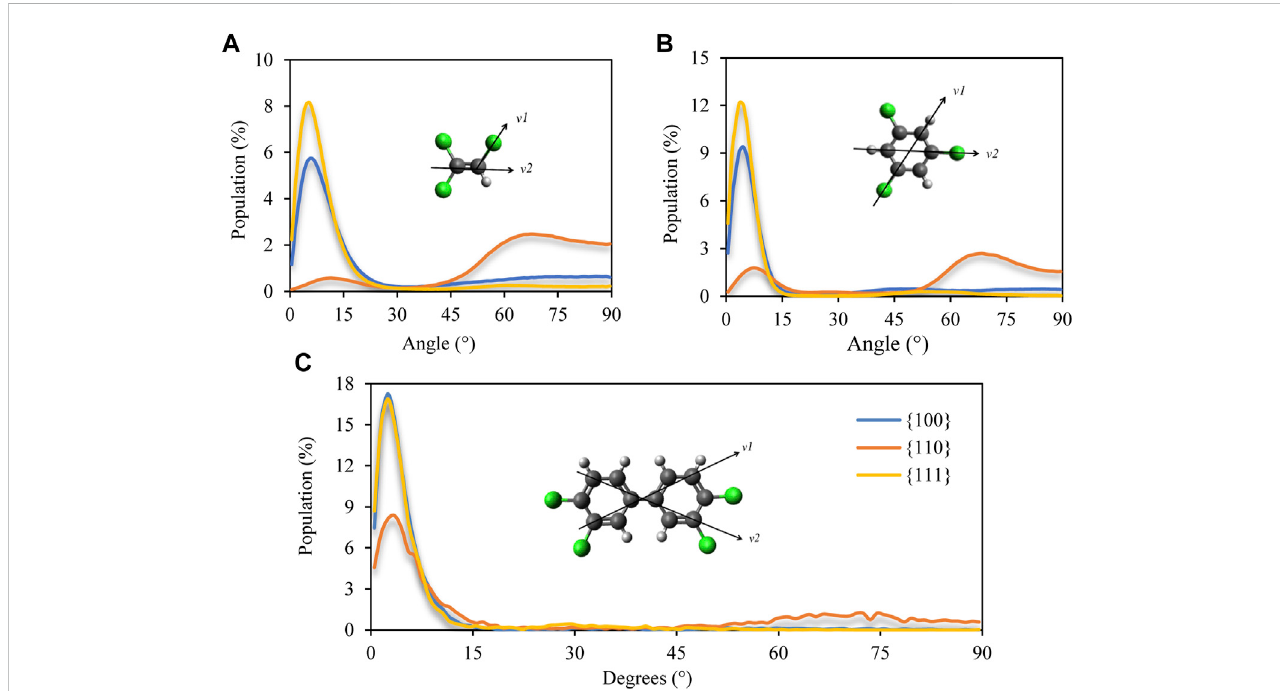
FIGURE 3 Distributionofanglesbetweenthemolecularface-normalvector(de fi nedbythecrossproductofvectorsv1andv2)andsubstratenormaldirection.Data for (A) TCE at 230 K, (B) for TCB at 360 K and (C) for PCB77 at 500 K. Zero degree implies average parallel orientation with respect to Pd surface (face- fl at) while 90 degrees implies perpendicular (standing)